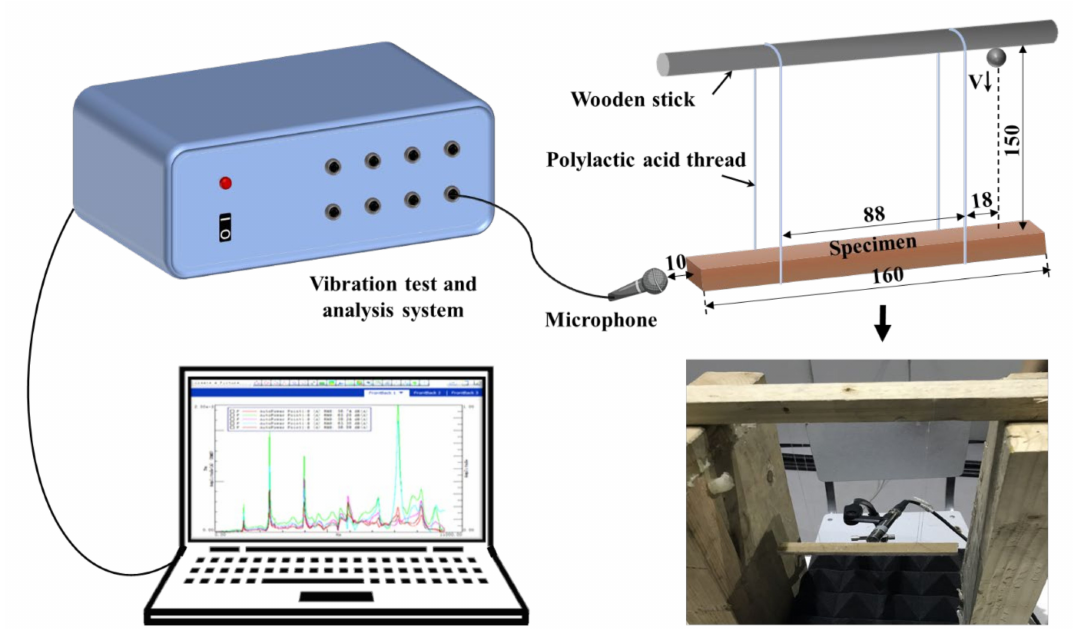
Figure 2. Schematic diagram and real image of lateral free vibration testing system. The dimensions in the figure are all in